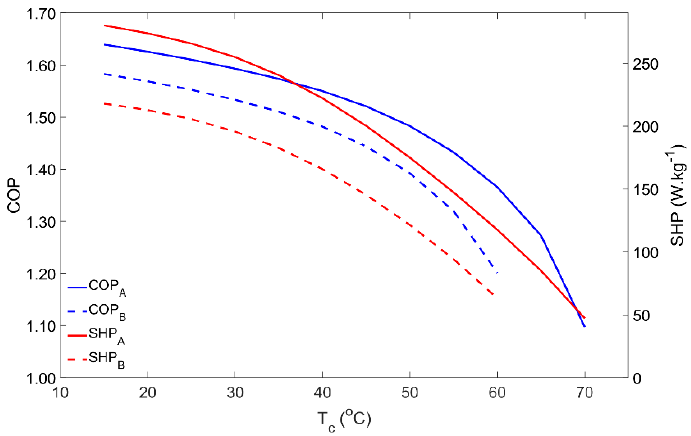
Figure 4. Influence of the condenser temperature on the adsorber performance for scenarios A and B.